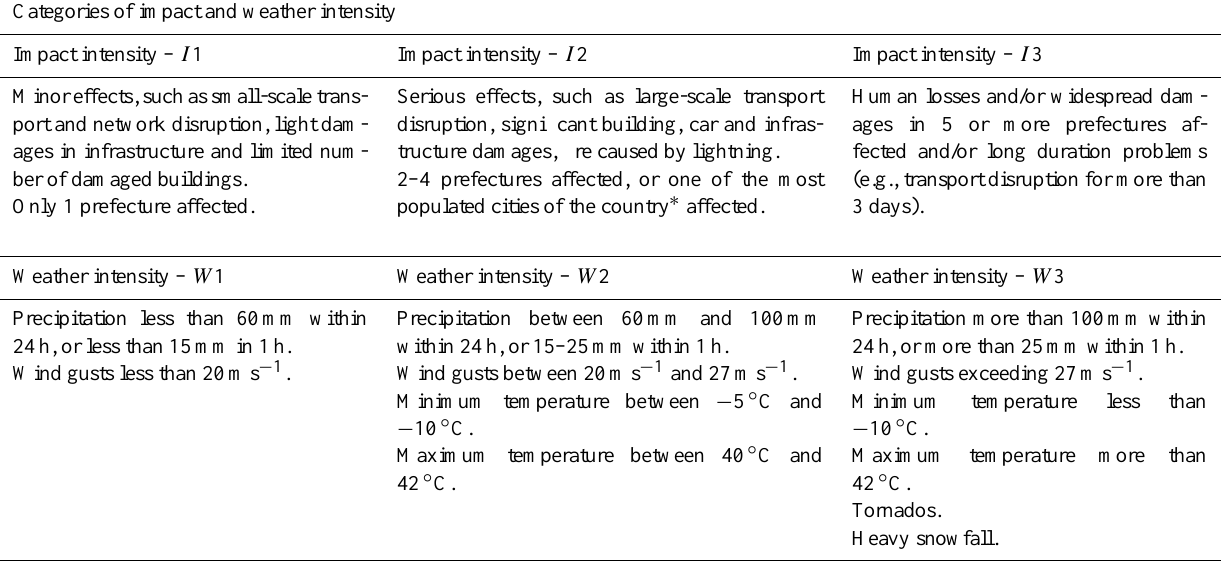
Table 1. Categories of impact and weather intensity.